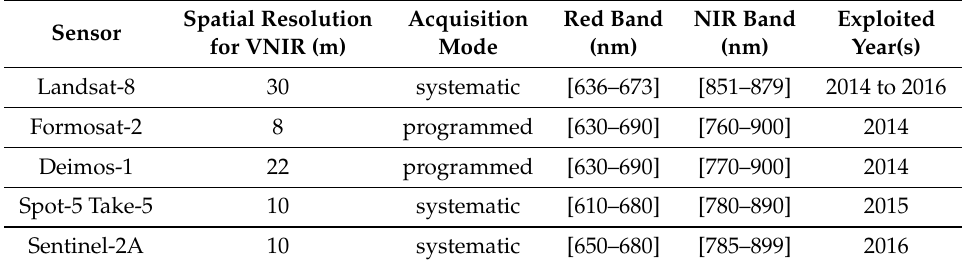
Table 1. Main characteristics of sensors in terms of spatial resolution, acquisition mode, spectral bands and selected years.